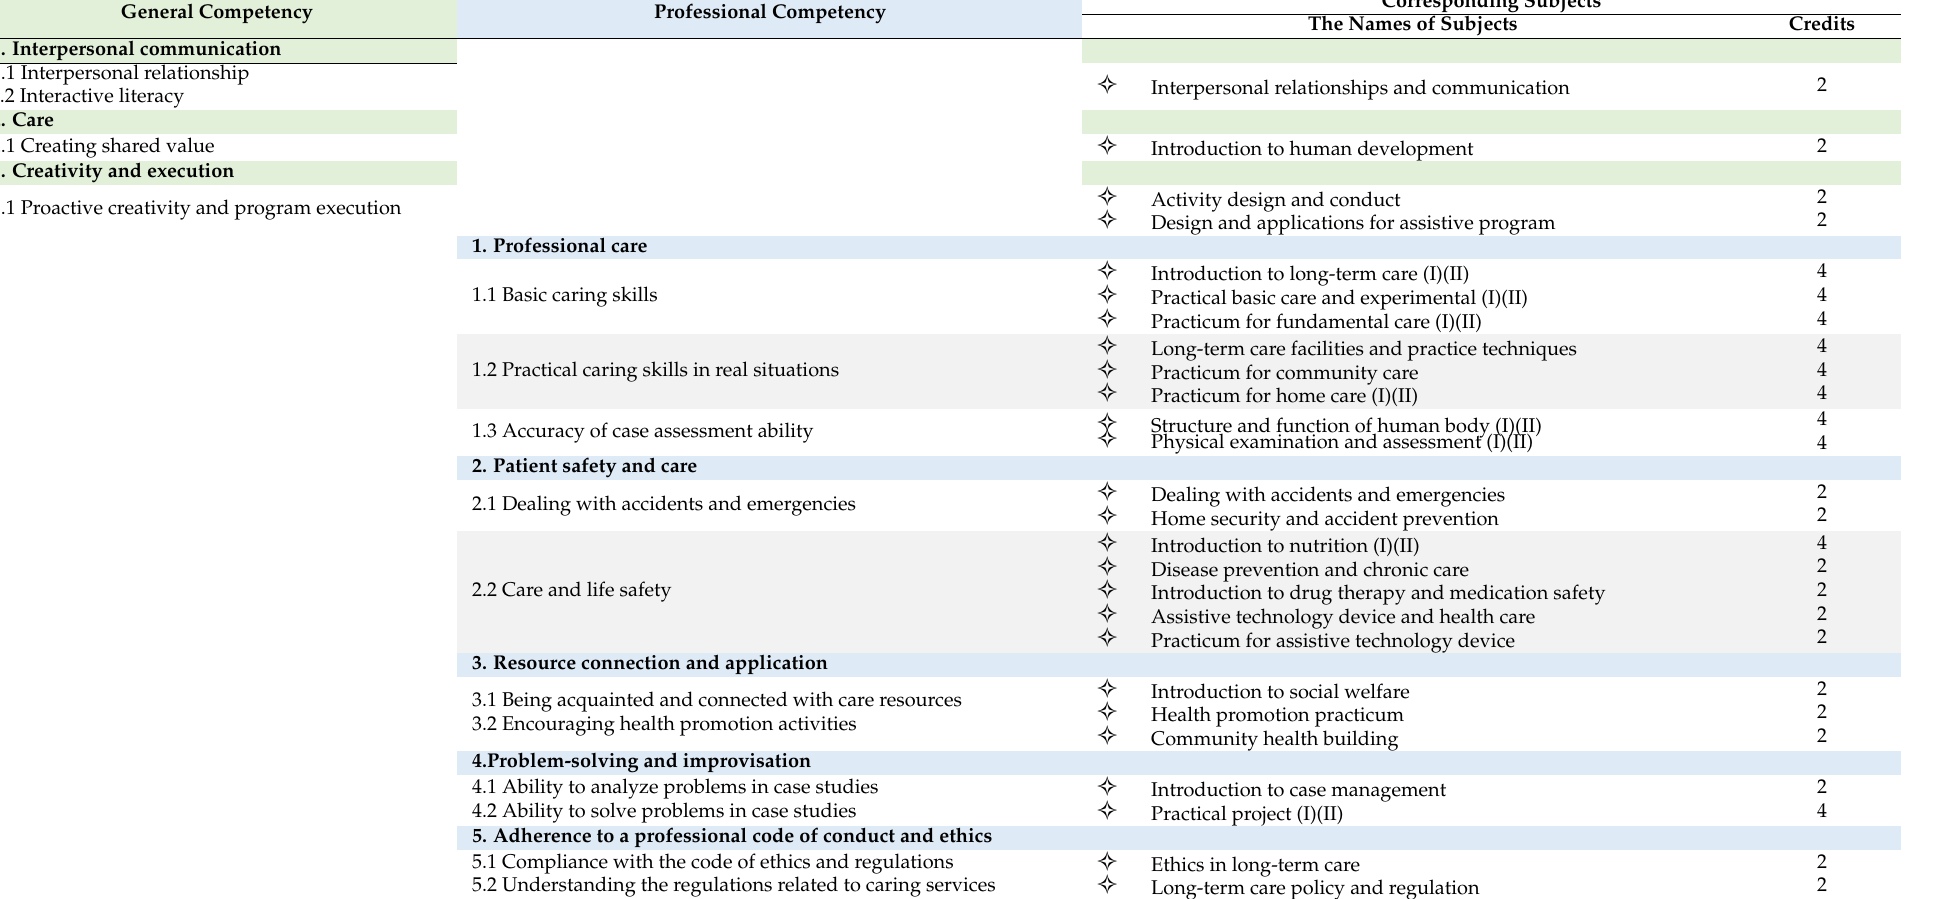
Corresponding Subjects The Names of Subjects Credits